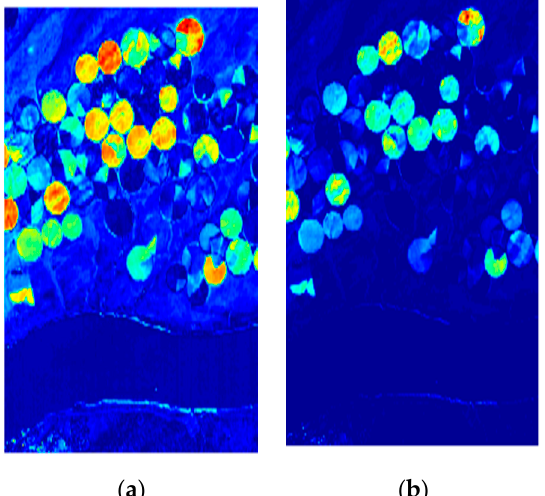
Figure 8. The di ff erence between ( a ) simple di ff erencing and ( b ) norm l 2 in discriminating change and Figure 8. The difference between ( a ) simple differencing and ( b ) norm l 2 in discriminating change and no-change areas for Hyperspectral-Farmland no-change areas for Hyperspectral-Farmland datasets.